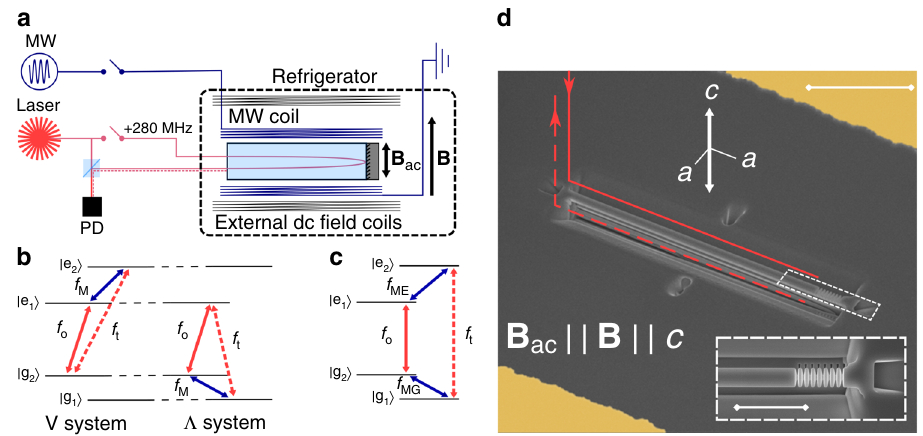
Fig. 1 Concept and miniaturized implementation of a rare-earth ion magneto-optic modulator. a Conceptual schematic of the REI magneto-optic modulator. A microwave fi eld B ac is transduced to an optical fi eld (dotted coral line) using a REI ensemble in a crystal. The crystal is coupled to a microwave transmission line (MW coil) and pumped by a laser fi eld (solid coral line). Magnetic fi eld coils provide control of the external dc fi eld B .